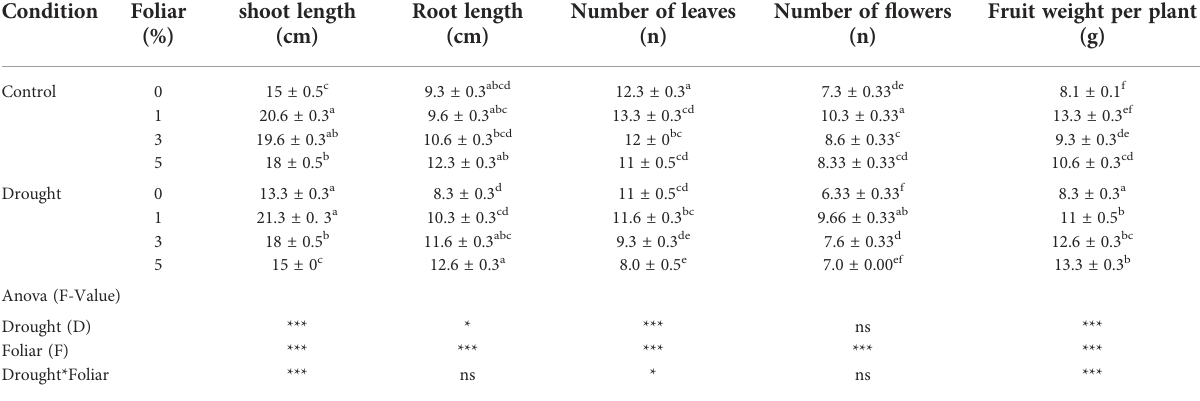
TABLE 1A The effect of foliar application of nano-nutrient solution on growth attributes of tomato under drought stress. Condition